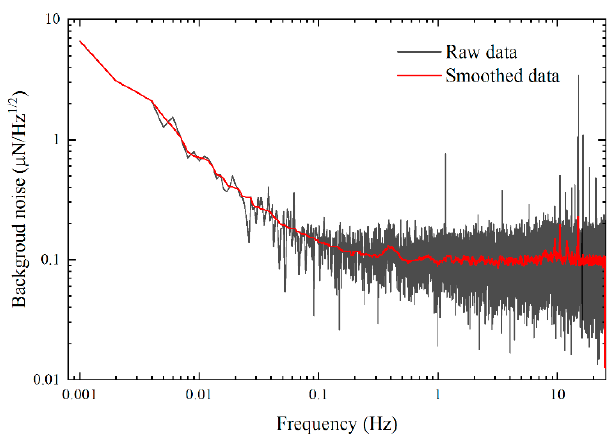
Figure 17. Power spectrum density of 0.001–25 Hz frequency band.